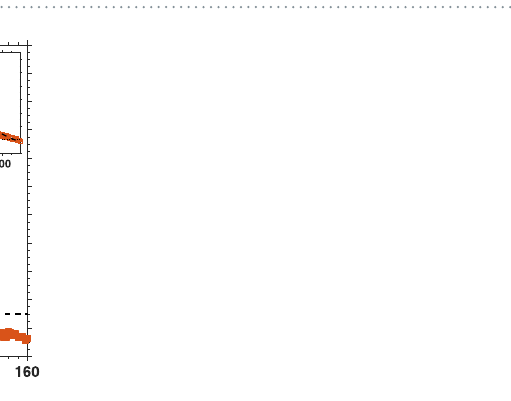
Figure 3. Pulsed LIAD of 209 Fr from PDMS. 209 Fr MOT population time evolution after a broadband light pulse at t = 0 s. The vertical arrow marks the beginning of LIAD. The horizontal dashed line indicates the equilibrium MOT population.